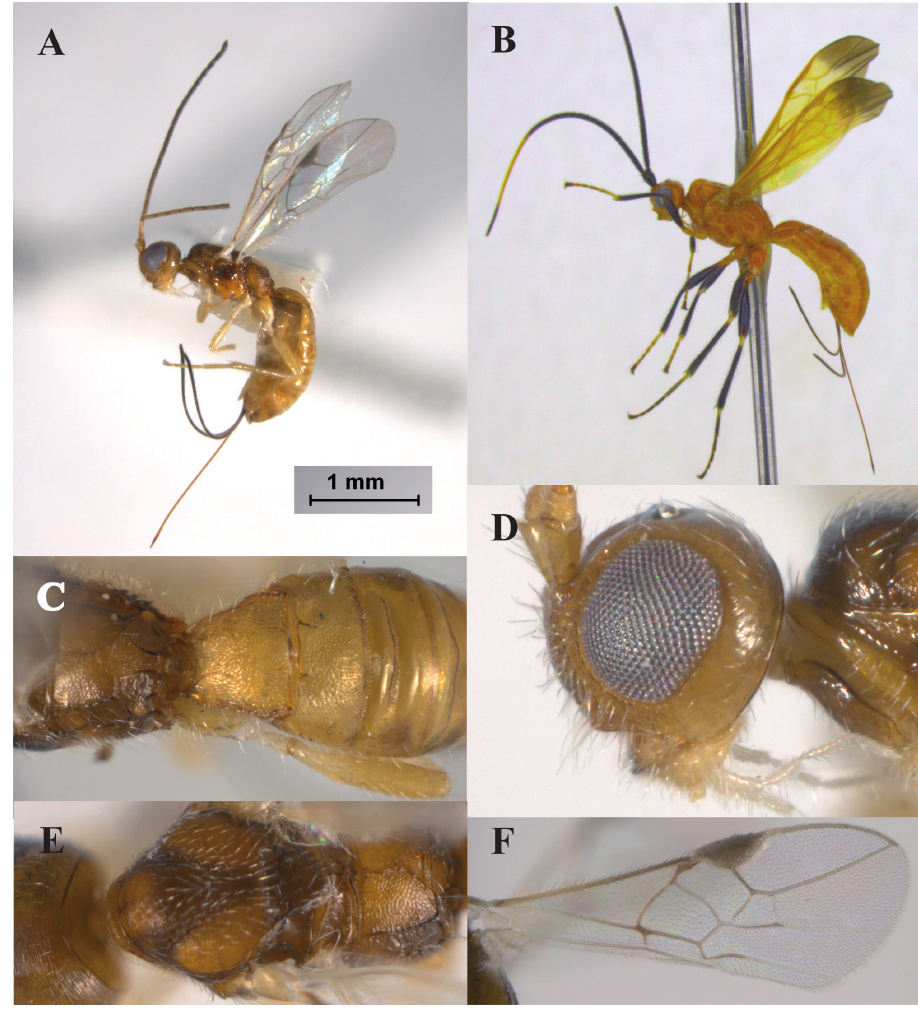
Figure 2. Heerz ecmhala sp. n. (holotype) ( A, C–F ) and Heerz lukenatcha Marsh ( B ): A, B habitus, lateral view C propodeum and basal half of metasoma, dorsal view D head, lateral view e mesosoma, dorsal view F fore